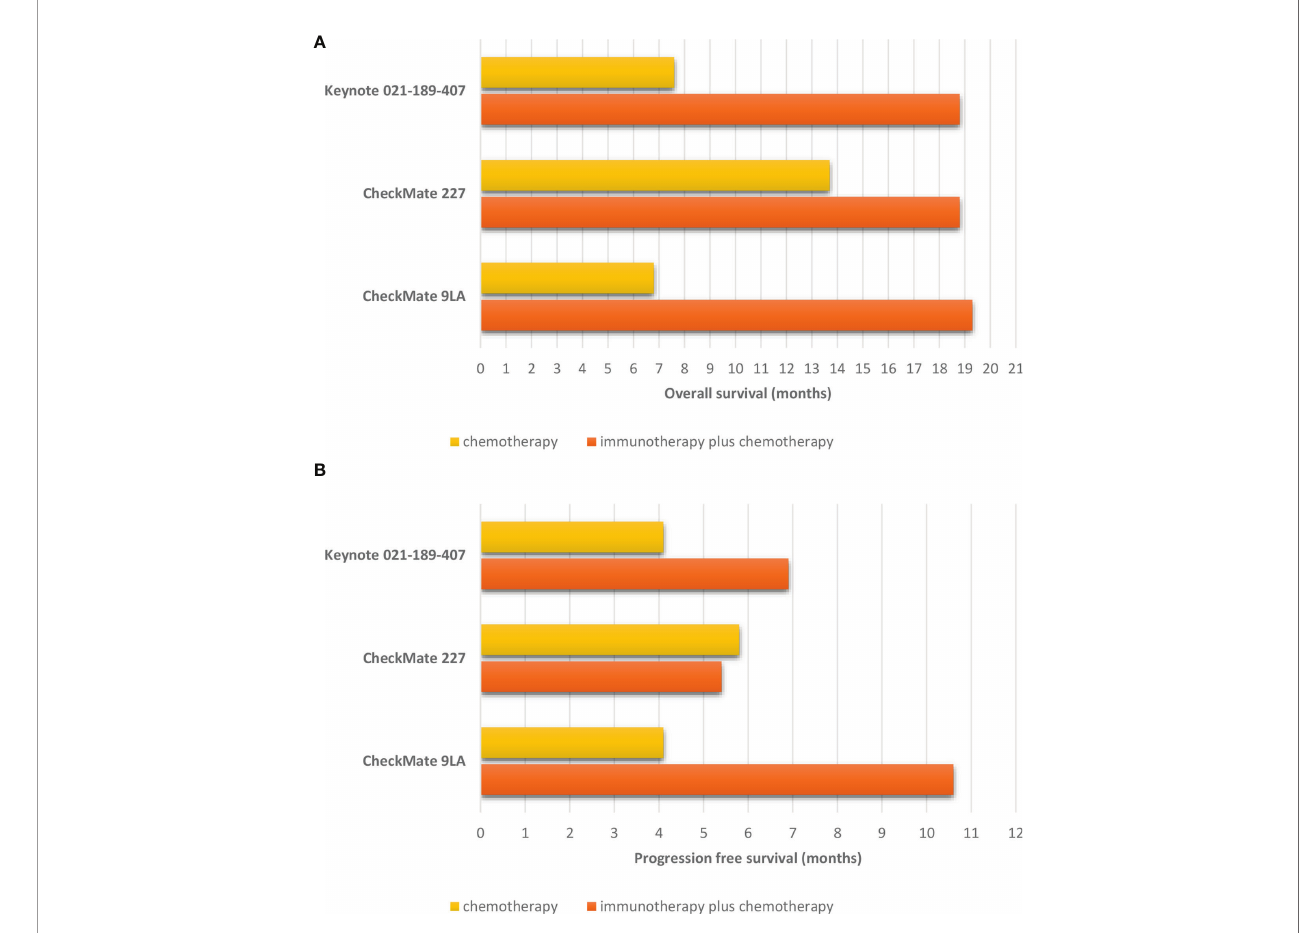
FIGURE 3 | Survival in non-small cell lung cancer patients with pre-treated and stable brain metastases treated in randomized trials comparing immune checkpoint inhibitors combined with chemotherapy to chemotherapy alone. (A) Overall survival. (B) Progression free